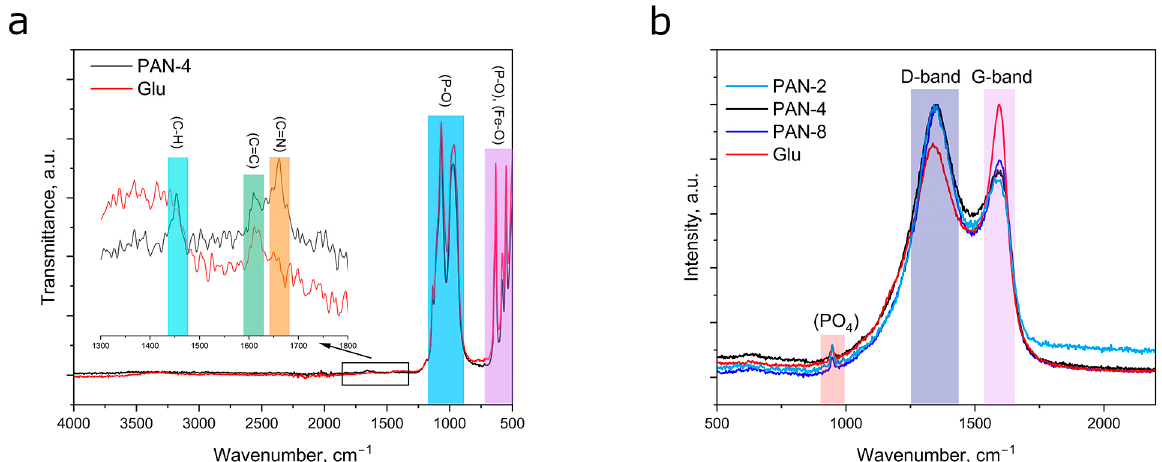
Figure 4. Raman spectra of PAN and Glu samples representing D and G band distribution of the composites ( a ) and IR spectra of PAN- and Glu-coated Li-rich LFMP samples with magnified region of organic functional groups signals ( b ).